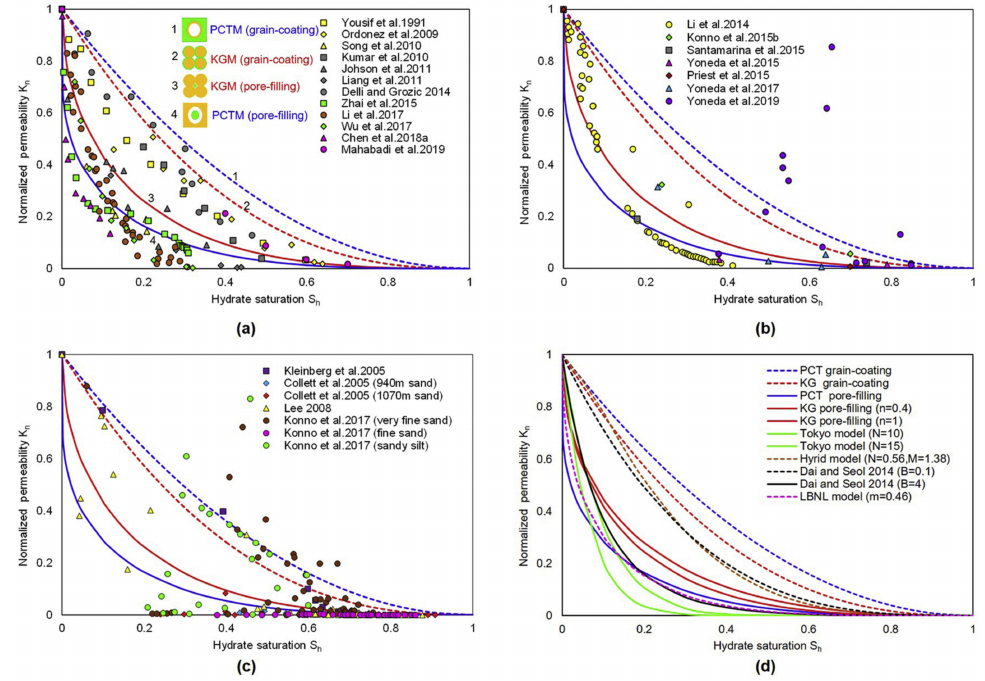
Figure 44. The relationship between normalized permeability and hydrate saturation reprinted from [10] with permission from Elsevier. ( a ) Data from laboratory synthesized spec- imens [24,27,55,82,89,95,111,112,128–131]; ( b ) data from pressure-core samples [97,114,132–136]; ( c ) data obtained from well log analysis [11,90,94,137]; ( d ) data obtained from existing widely used models in the literatures